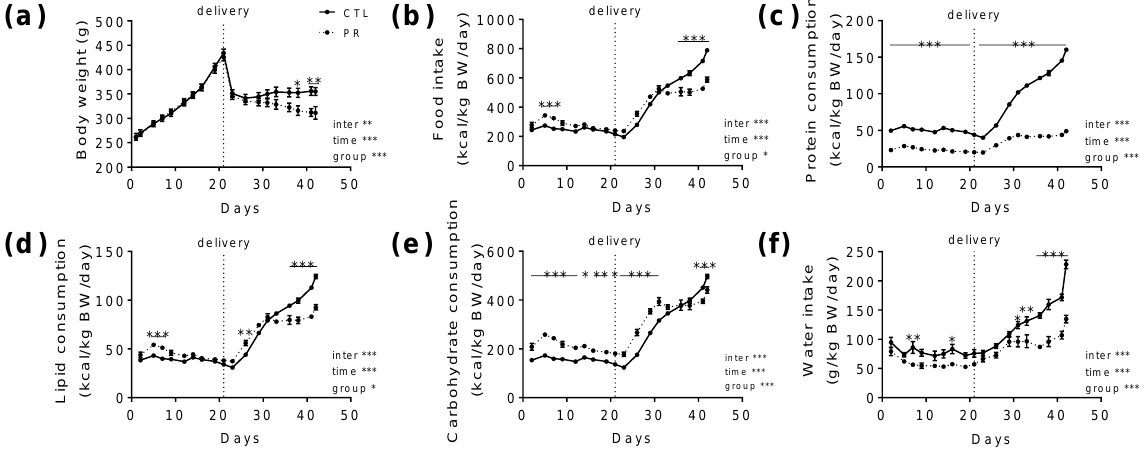
Figure 2. Dams follow-up during gestation and lactation. Body weight ( a ); food intake ( b ); protein ( c ), lipid ( d ), and carbohydrate ( e ) consumption; and water intake ( f ) are presented during gestation (from D1 to D21) and lactation (from D22 to D42). Solid line, CTL; Dotted line, PR. Vertical dotted line at D21 indicates delivery. CTL, control. PR, protein restriction, BW, body weight. Data are mean ± SEM ( n = 8–13). * p < 0.05, ** p < 0.01, *** p < 0.001 vs. CTL, 2-way ANOVA with Sidak post-test.